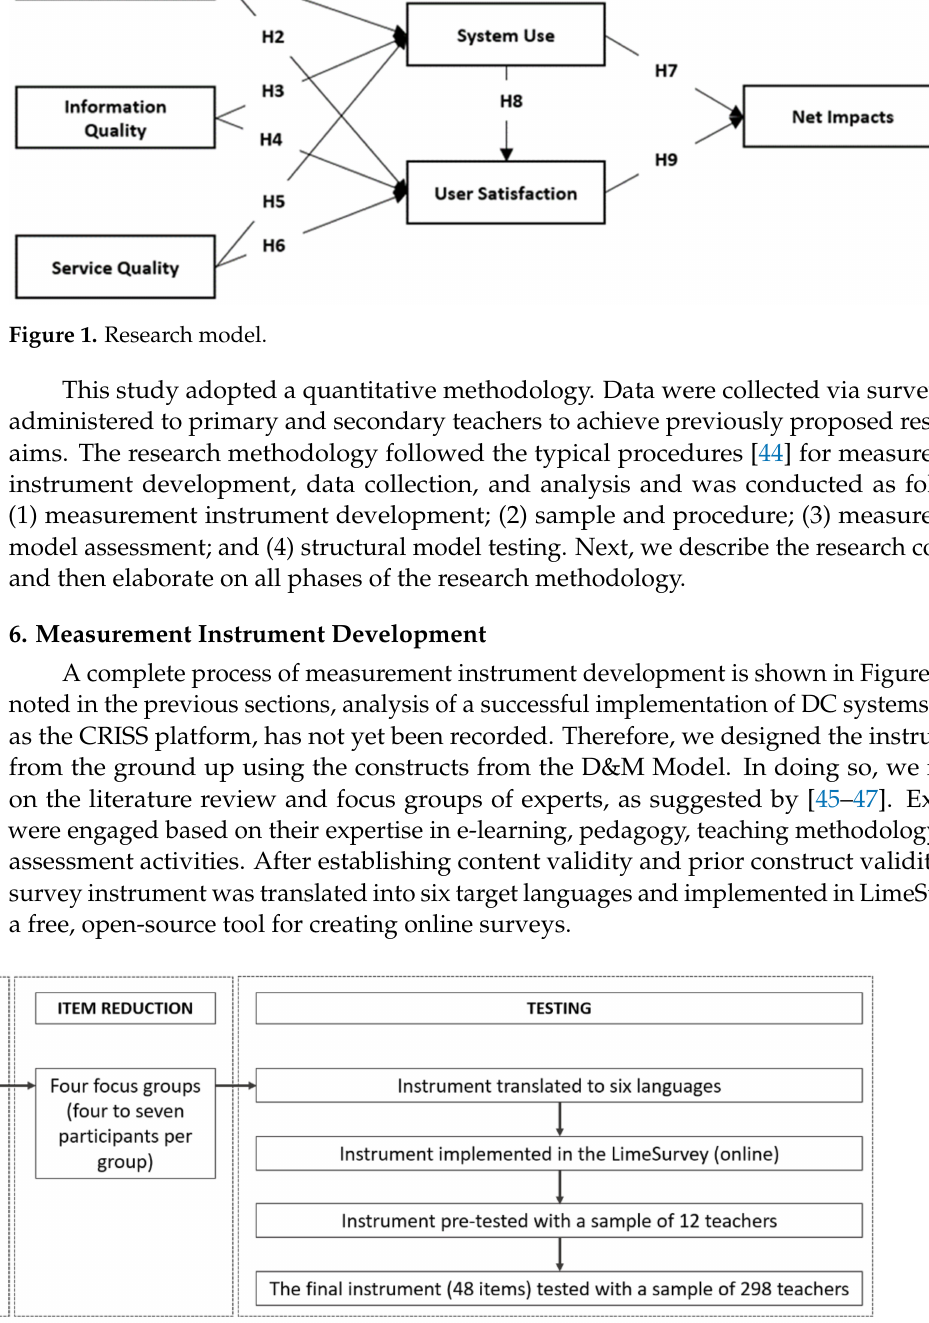
Figure 2. The process of measurement instrument